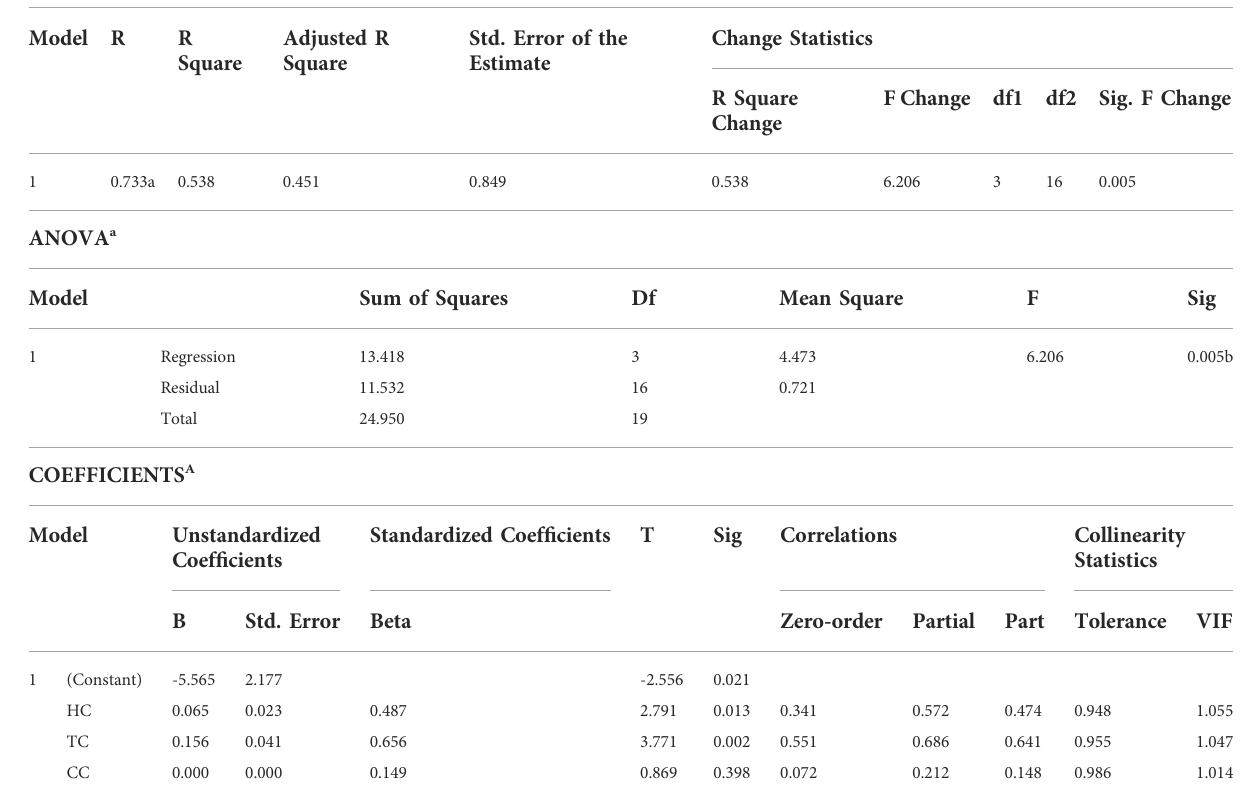
TABLE 9 Model summary, ANOVA, and coef fi cients of body